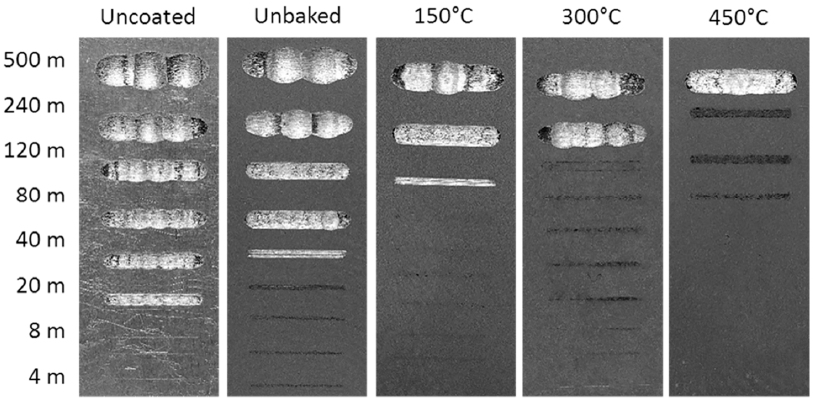
Figure 11. Images of the linear reciprocating trails.